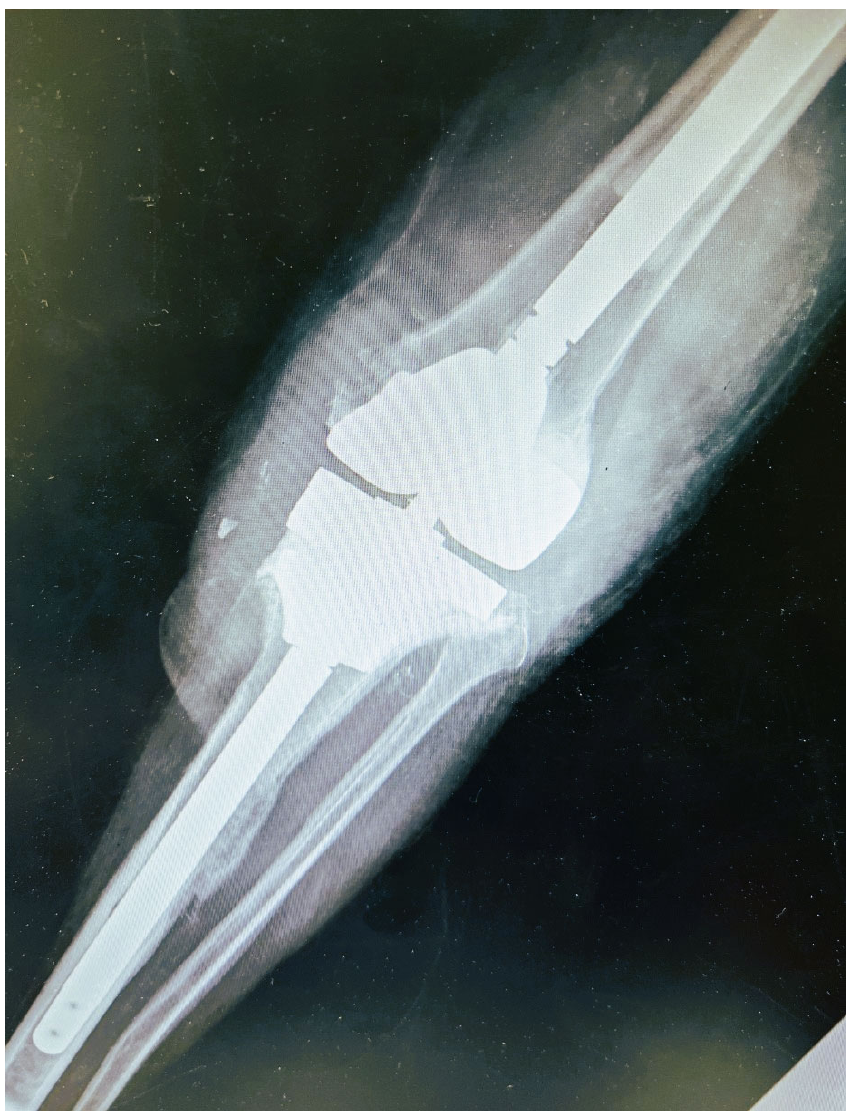
Figure 2. Post ‐ operative anteroposterior X ‐ ray view. A constrained prosthesis with long femoral and tibia stems was placed. A tantalum porous scaffold was placed in the proximal tibia due to bone loss, while augments supported the femoral and tibia components.